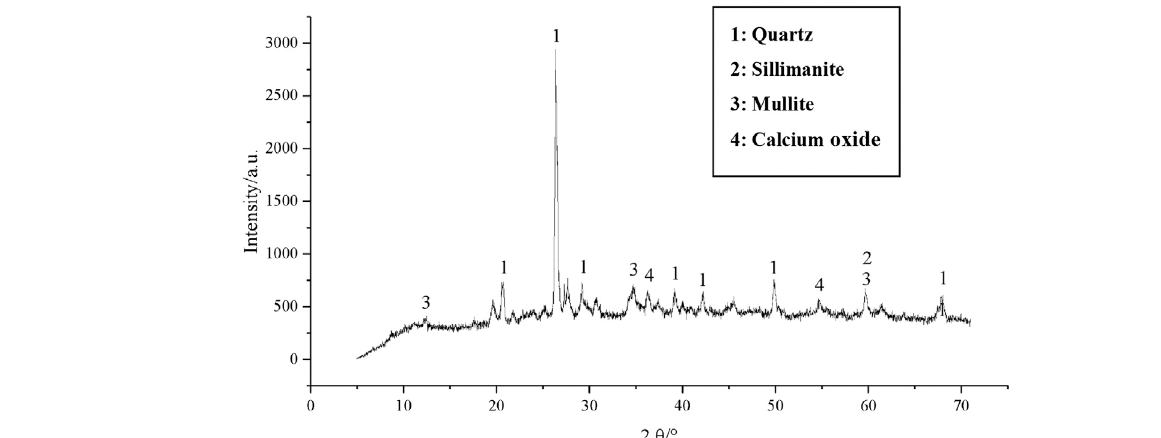
Frontiers in Materials |